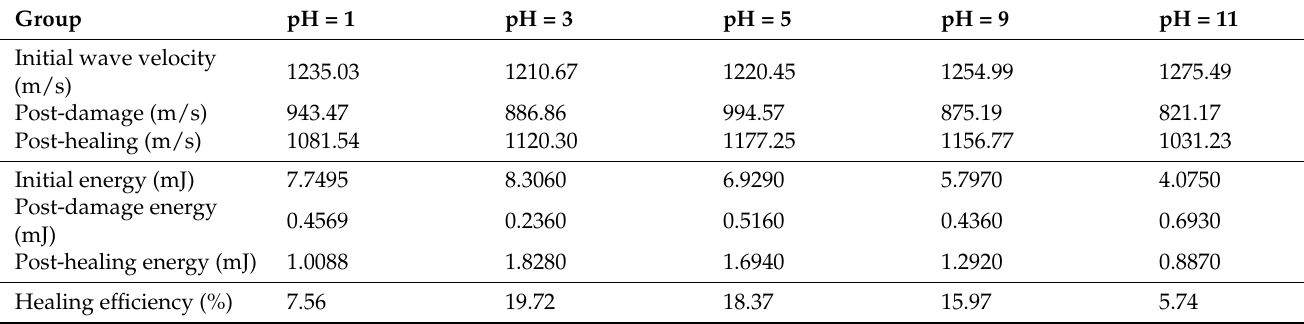
Figure 15. Healing efficiency of microcapsules in various water environments. Table 7. Comparison of healing effect of microcapsules in various water